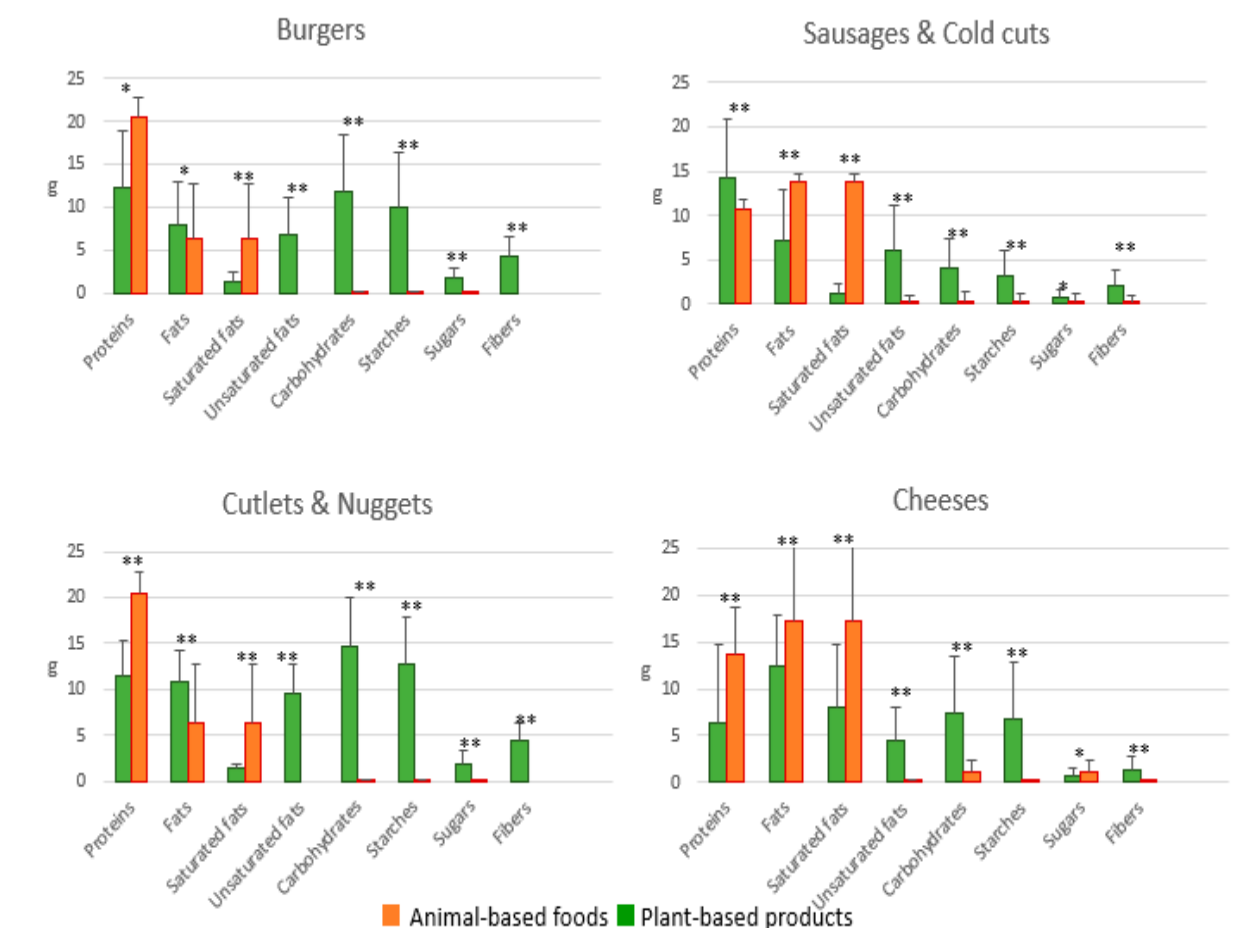
Figure 3. Macronutrients and fiber composition of processed plant-based products vs. regular animal-based foods * p < 0.05; ** p < 0.01. All the data were presented as mean ± SD.